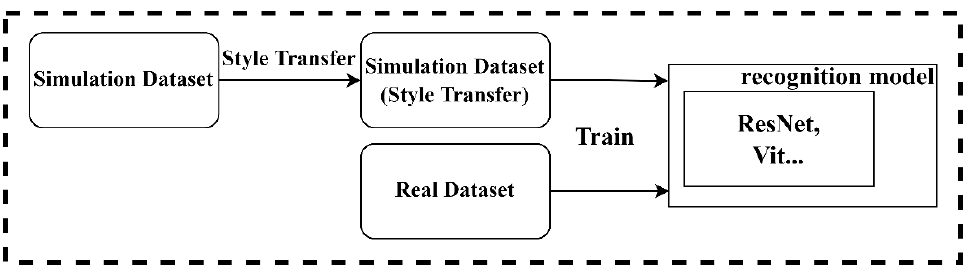
Figure 6. Training process. Figure 6. Training